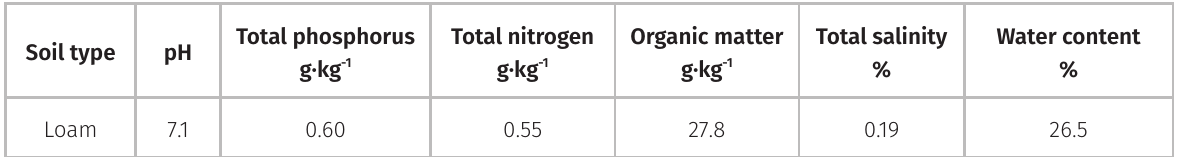
Table I. Basic physic-chemical characteristics of fresh soil.